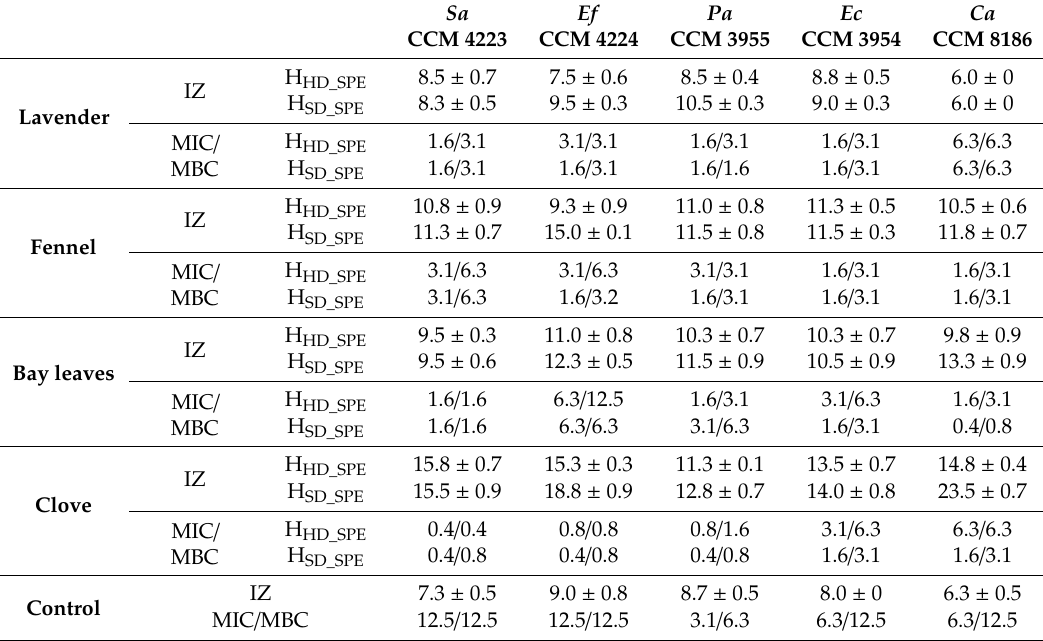
Table 7. Antimicrobial activity of hydrolates concentrated by SPE on selected microorganisms—mean inhibition zones in mm (including disc 6 mm in diameter) ± standard deviation or minimal inhibitory concentrations in %, n =